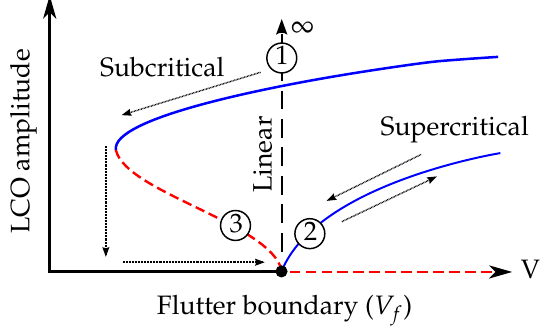
Figure 2. Generic flutter boundary possibilities: (1) linear, (2) supercritical Hopf bifurcation and (3) subcritical Hopf bifurcation. Blue = stable, red = unstable.